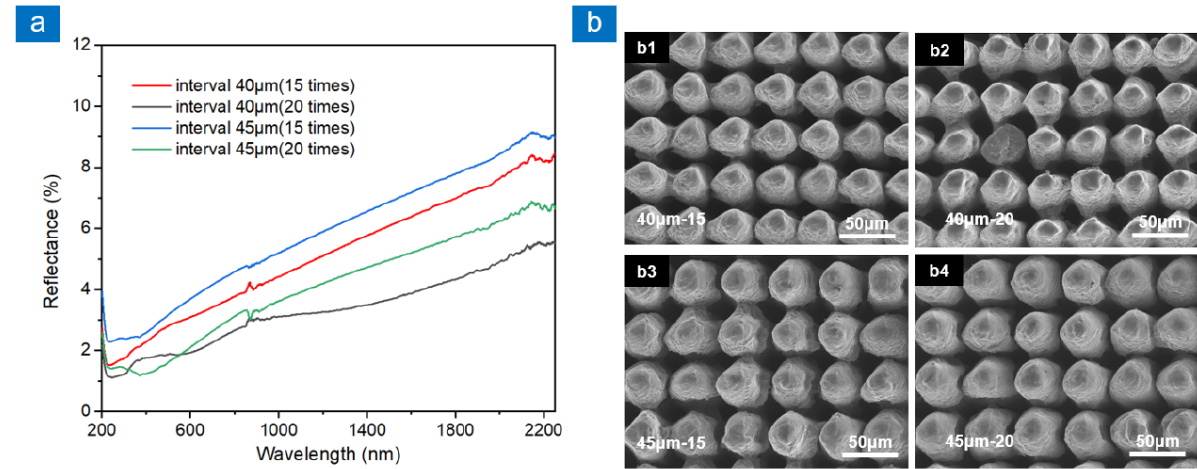
Figure 3. Reflection spectra and SEM images of multi-scale structures at different laser scanning intervals and times. ( a ) Reflectance spectra of four samples, ( b ) SEM images of four samples: ( b1 ) the scanning interval is 40 µ m and scanning times are 15, ( b2 ) the scanning interval is 40 µ m and scanning times are 20, ( b3 ) the scanning interval is 45 µ m and scanning times are 15, ( b4 ) the scanning interval is 45 µ m and scanning times are 20.